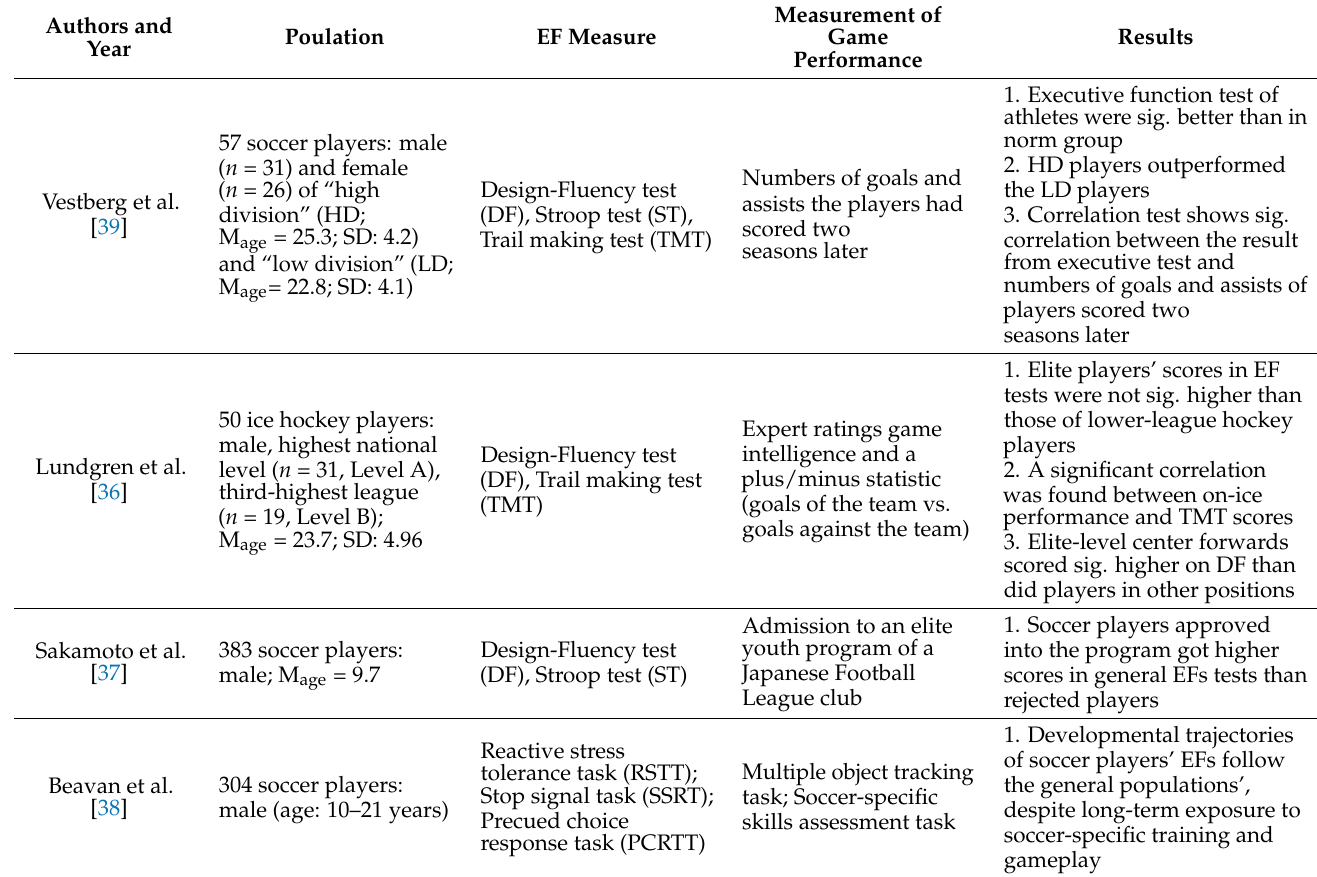
Table A1. Studies examining the relations between executive functions (EFs) and game performance.